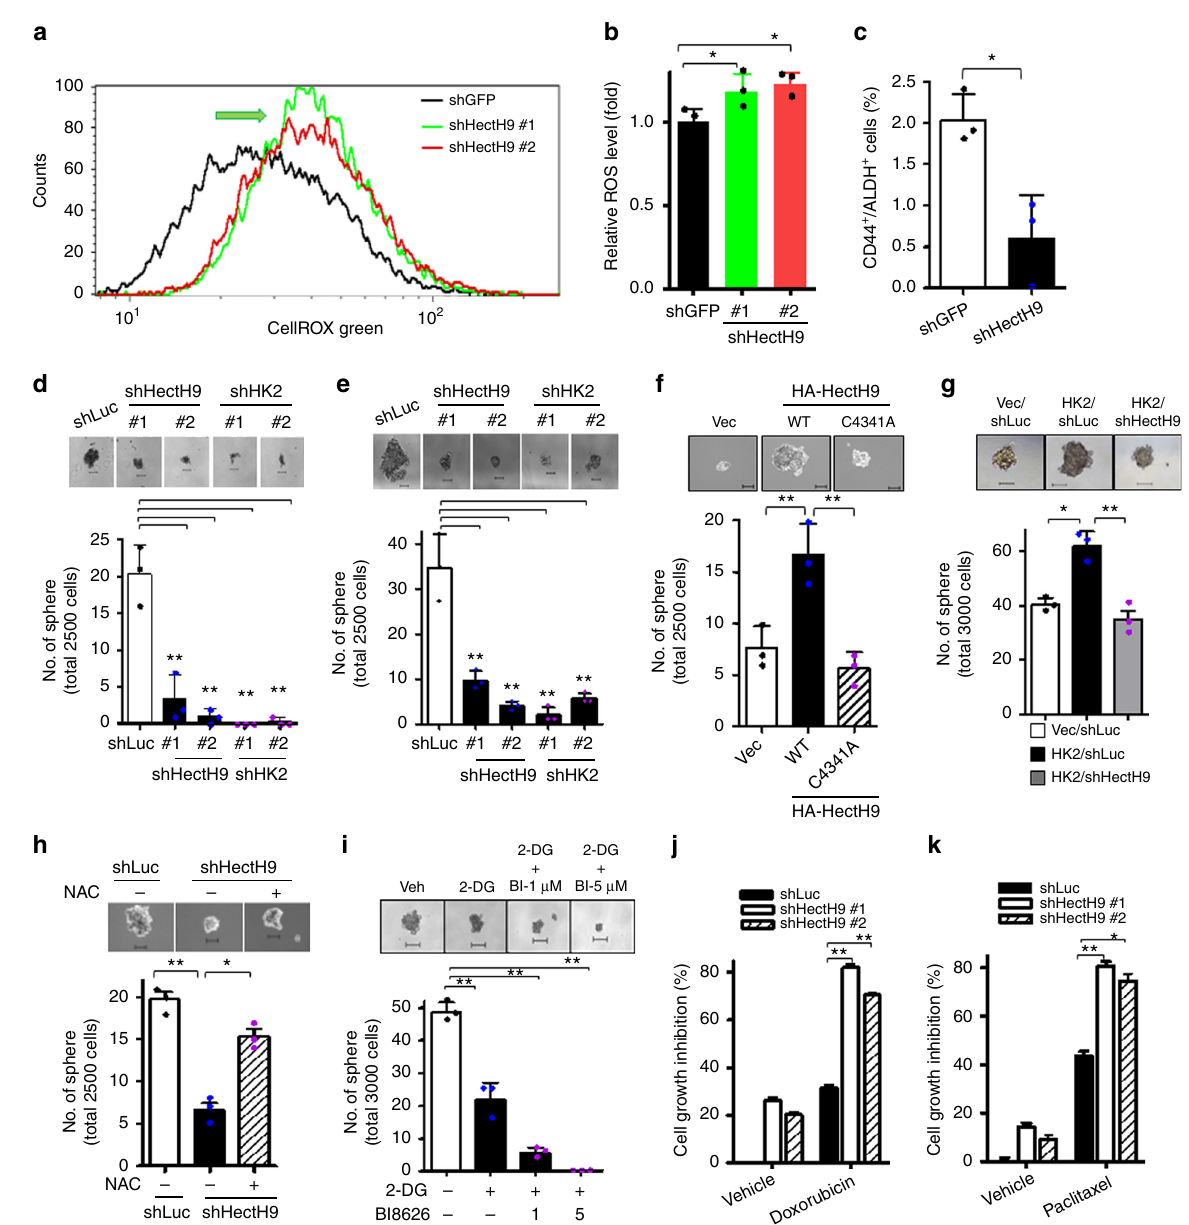
Fig. 6 De fi ciency in HectH9 or HK2 inhibits CSC self-renewal via ROS production. a Representative image of fl ow cytometry analysis for ROS production in PC-3 cells with GFP or HectH9 knockdown. Green arrow indicates higher ROX level in HectH9-knockdown PC-3 cells. b Quantitative results for ROS production in PC-3 cells with GFP or HectH9 knockdown. Data were collected from three independent experiments. c Populations of CD44 + /ALDH + cells were determined by fl ow cytometry analysis in PC-3 cells with GFP or HectH9 knockdown ( n = 3). d and e Tumor sphere formation assays in PC-3 ( d ) and HeLa ( e ) cells with Luciferase, HectH9 or HK2 knockdown ( n = 3). Scale bar represents 100 μ m. f Tumor sphere formation assay in HeLa cells infected with lentiviruses containing shRNA targeting the 3 ’ -UTR of HectH9, followed by restoration with vector control, catalytically active form (WT) or defective mutant (C4341A) of HA-HectH9 ( n = 3). Scale bar represents 100 μ m. g Tumor sphere formation assay in HeLa cells infected with viruses expressing vector control or HK2 overexpression, followed by Luciferase or HectH9 knockdown ( n = 3). Scale bar represents 100 μ m. h Tumor sphere formation assay in PC-3 cells with Luciferase or HectH9 knockdown in the absence and presence of NAC ( n = 3). Scale bar represents 100 μ m. i Tumor sphere formation assay in PC-3 cells incubated with vehicle, 2-DG alone or 2-DG and BI8626 in combination for 12 days ( n = 3). j and k Cell growth inhibition assay in PC-3 cells with Luciferase or HectH9 knockdown in the absence and presence of doxorubicin for 96 h ( j ) or paclitaxel for 48 h ( k ) ( n = 3). Cell numbers were counted by using a hemocytometer. Results are presented as mean value ± SD; * p < 0.05, ** p < 0.01, by Student ’ s t -test. Experiments were performed at least twice in